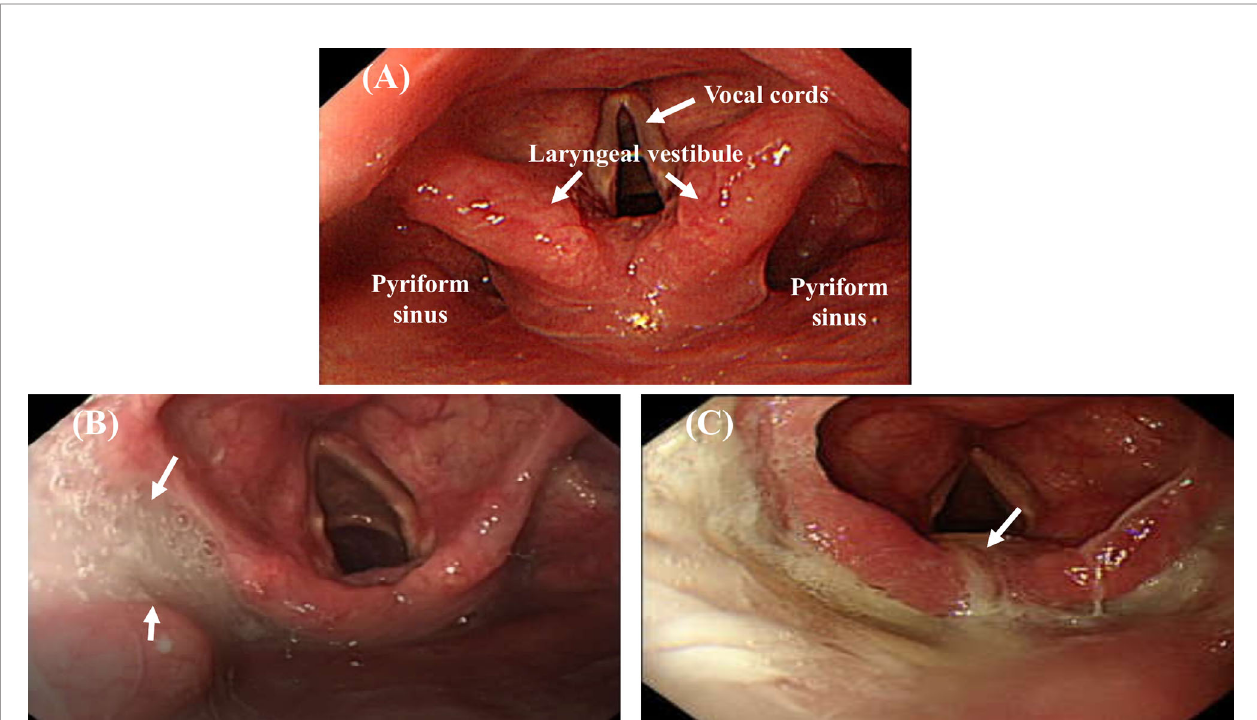
FIGURE 2 | Endoscopic views of pooled secretions (arrow) in the pharyngolaryngeal region. Absence of secretions fi lling the pharyngolaryngeal region (A) . A large amount of pooled secretions in the right side of the pyriform sinus but not entering the laryngeal vestibule (B) , and pooled secretions leaking into the laryngeal vestibule (C) .